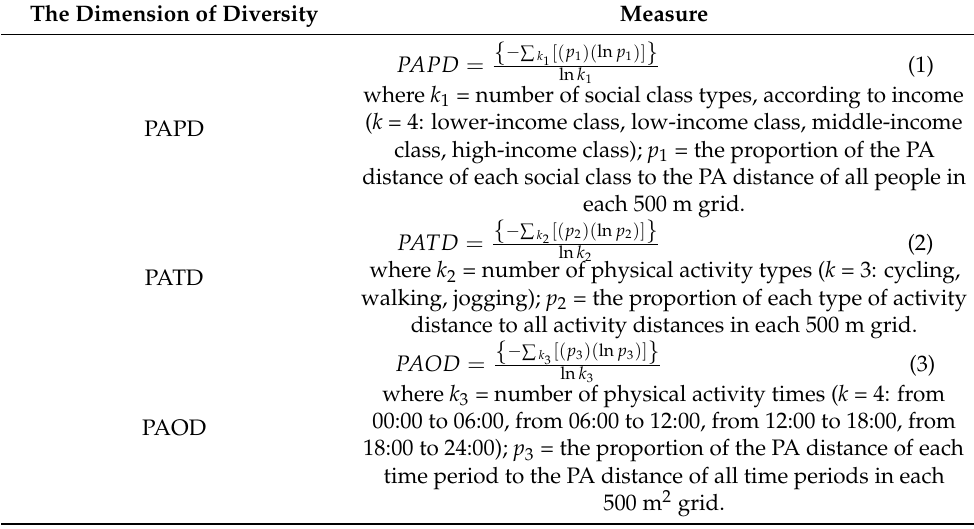
Table 1. Measures of the three dimensions of PA diversity. The Dimension of